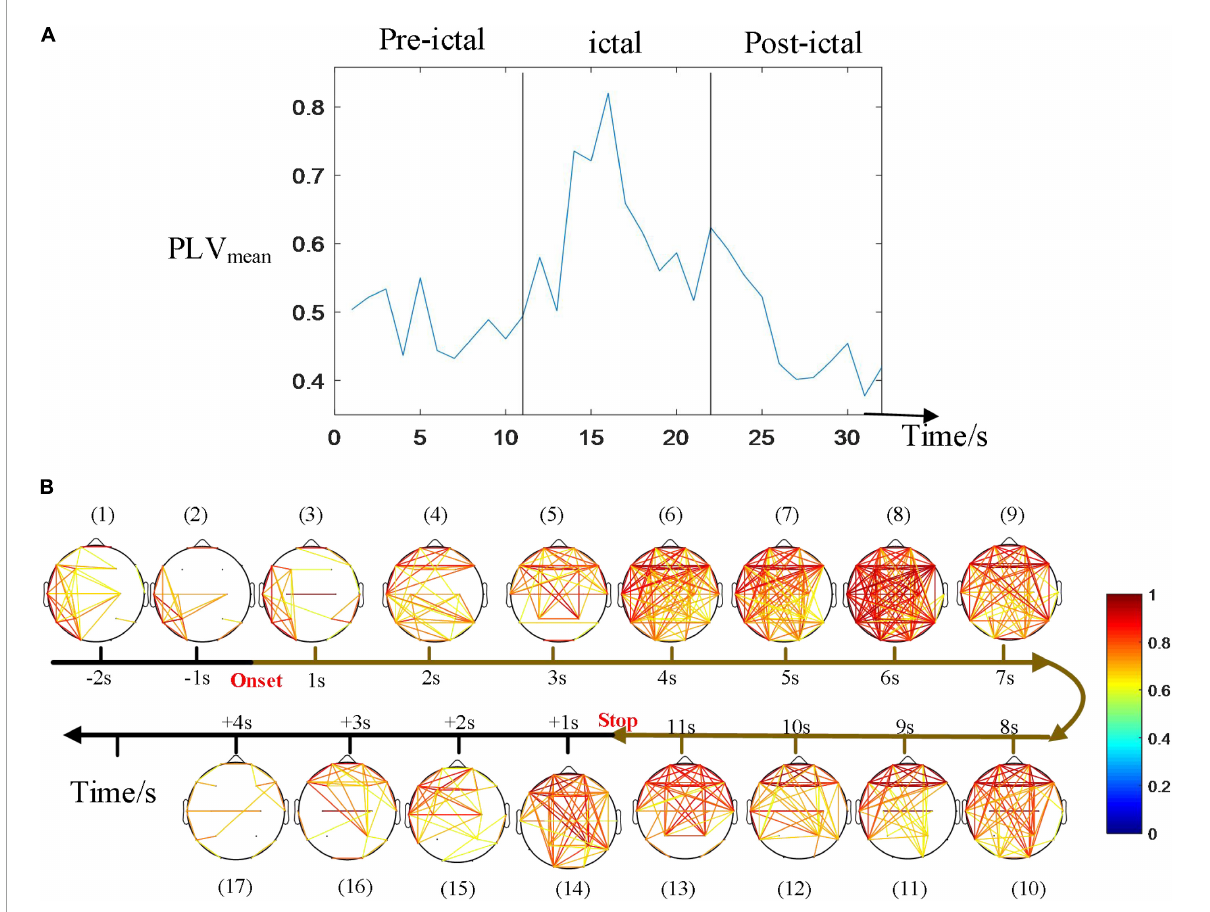
FIGURE5 Time courses of the synchronization. (A) The average of PLV during the seizure. (B) Dynamic network connectivity distributions. The strongest connectivity in (B) just corresponded to the maximum value of the PLV mean (at 6 s after onset in this seizure). The pattern of the evolution of network synchronous connectivity is consistent with that of the spatial diffusion range, both first increasing and then decreasing.